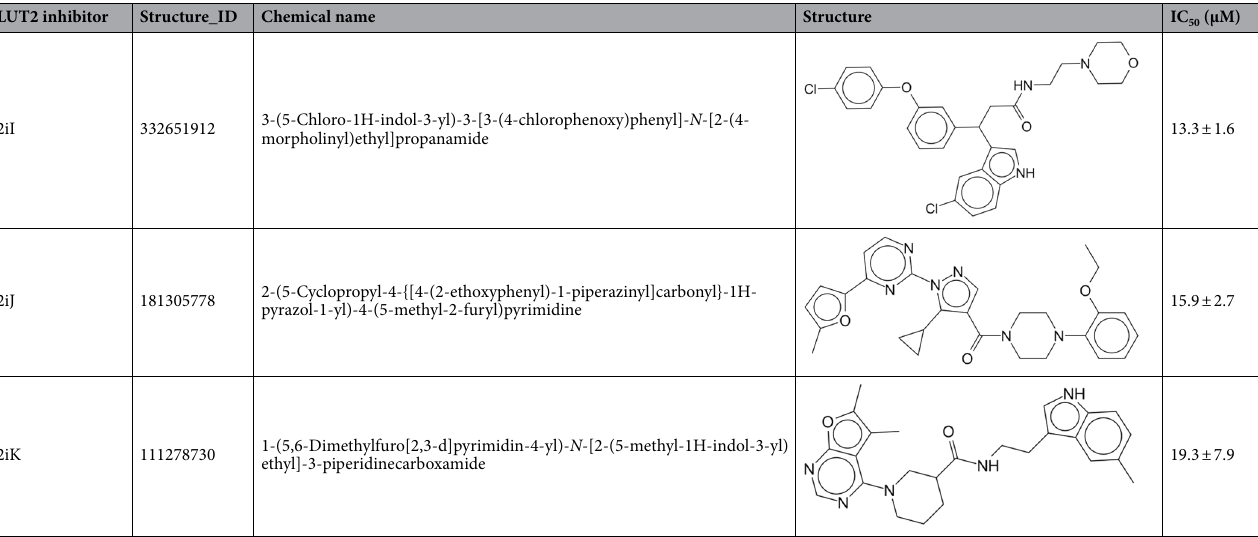
Table 1. Structures and chemical names of potent (IC 50 < 20 µM) GLUT2 inhibitors. Structure_ID refers to the ChemNavigator structure